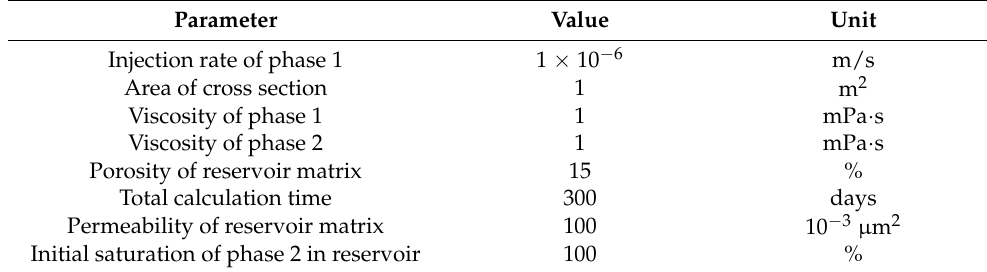
Table 1. Parameters for the validation of the numerical model [51].